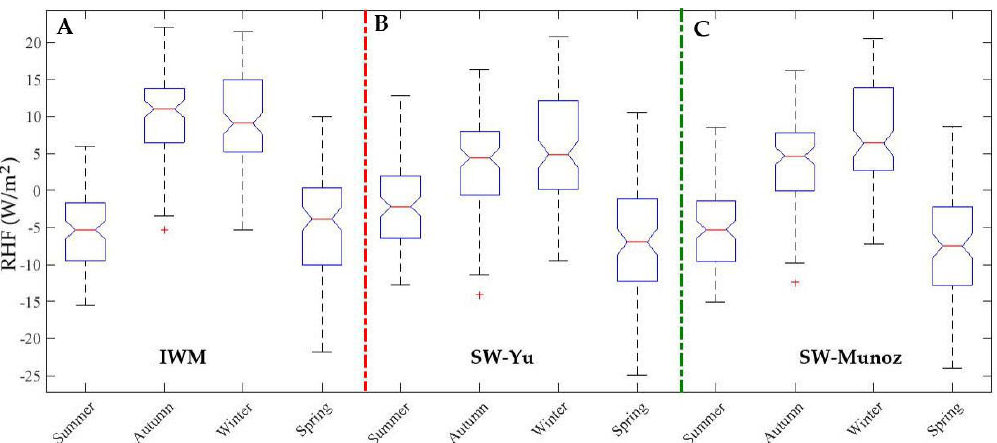
Figure 23. Seasonal variation in radiative heat flux (RHF) calculated using 101 random point samples of RHF, derived using three methods of land surface temperature (LST) estimation, namely: ( A ) RHFs based on LSTs derived from the improved mono-window algorithm (IMW); ( B ) RHFs based on LSTs derived from the split-window algorithm of Yu et al. [19] (SW-Yu); and ( C ) RHFs based on LSTs derived from the split-window algorithm of Jiménez-Muñoz et al. [20] (SW-Muñoz). The profile of A–B through the Hatchobaru geothermal area, shown in Figure 1, was used to evaluate the variation in the LST and RHF with NDVI in each season (Figure 24). We found that the mixed cover areas with NDVI values of less than 0.5 were associated with higher values of LST and RHF in the Hatchobaru geothermal area in all of the seasons (Figure 24). The higher values of NDVI (i.e., vegetated areas with some mixed non-thermal areas) had lower values of LST, with lower or even negative RHFs, especially where the LSTs were lower than the ambient temperatures (Figure 24).